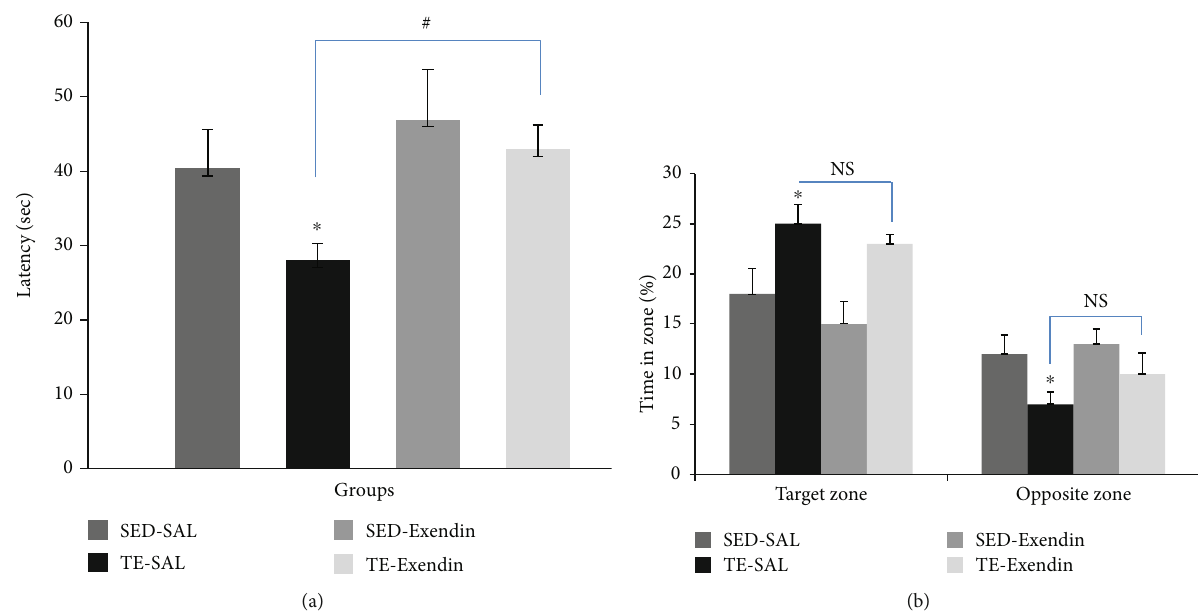
Figure 2: E ff ect of using the GLP-1-receptors antagonist (exendin-3) during treadmill exercise on memory tested by the MWM task. (a) Mean escape latencies. (b) Meantime spent in the target zone. Data are expressed as the mean ± SEM . ∗ is for P < 0 : 05 and # is for P < 0 : 01